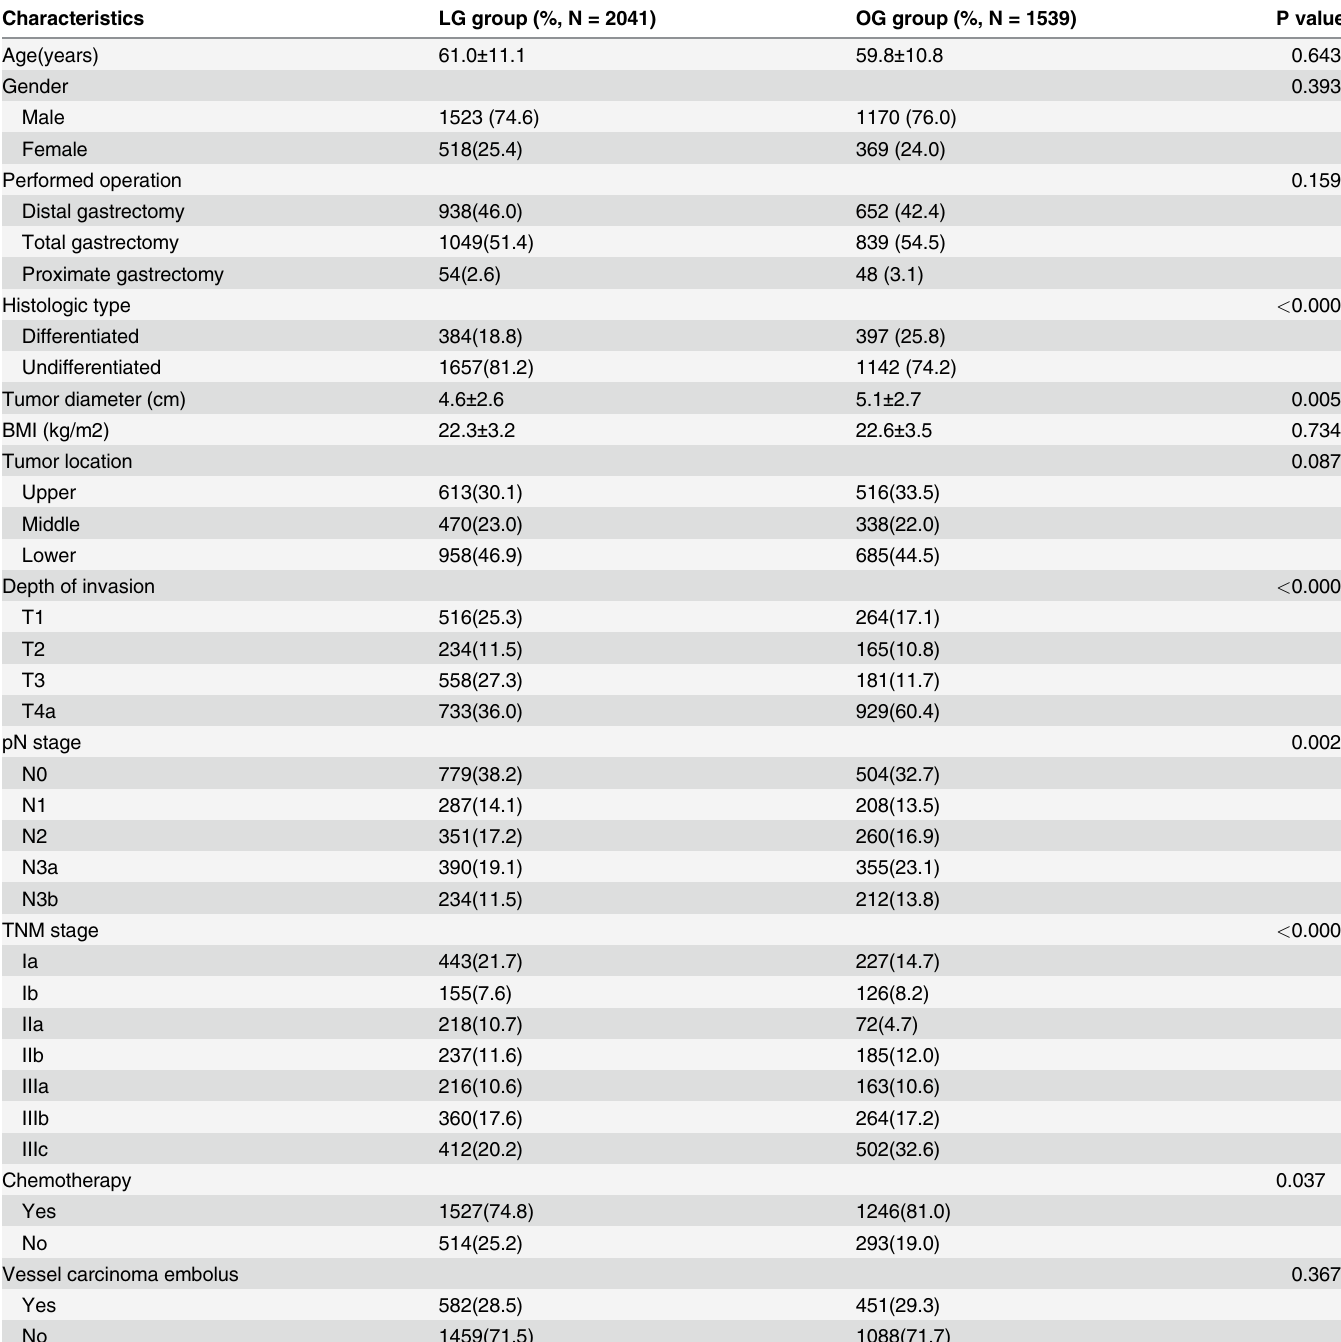
Table 1. Clinicopathological Characteristics of patients (n =